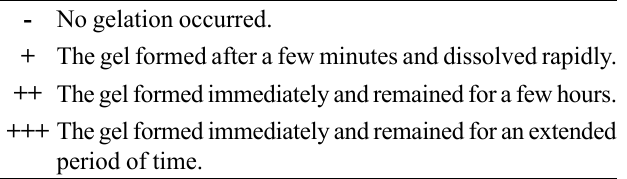
TABLE II - Grading of gelling capacities - No gelation occurred. + The gel formed after a few minutes and dissolved rapidly. ++ The gel formed immediately and remained for a few hours. +++ The gel formed immediately and remained for an extended period of